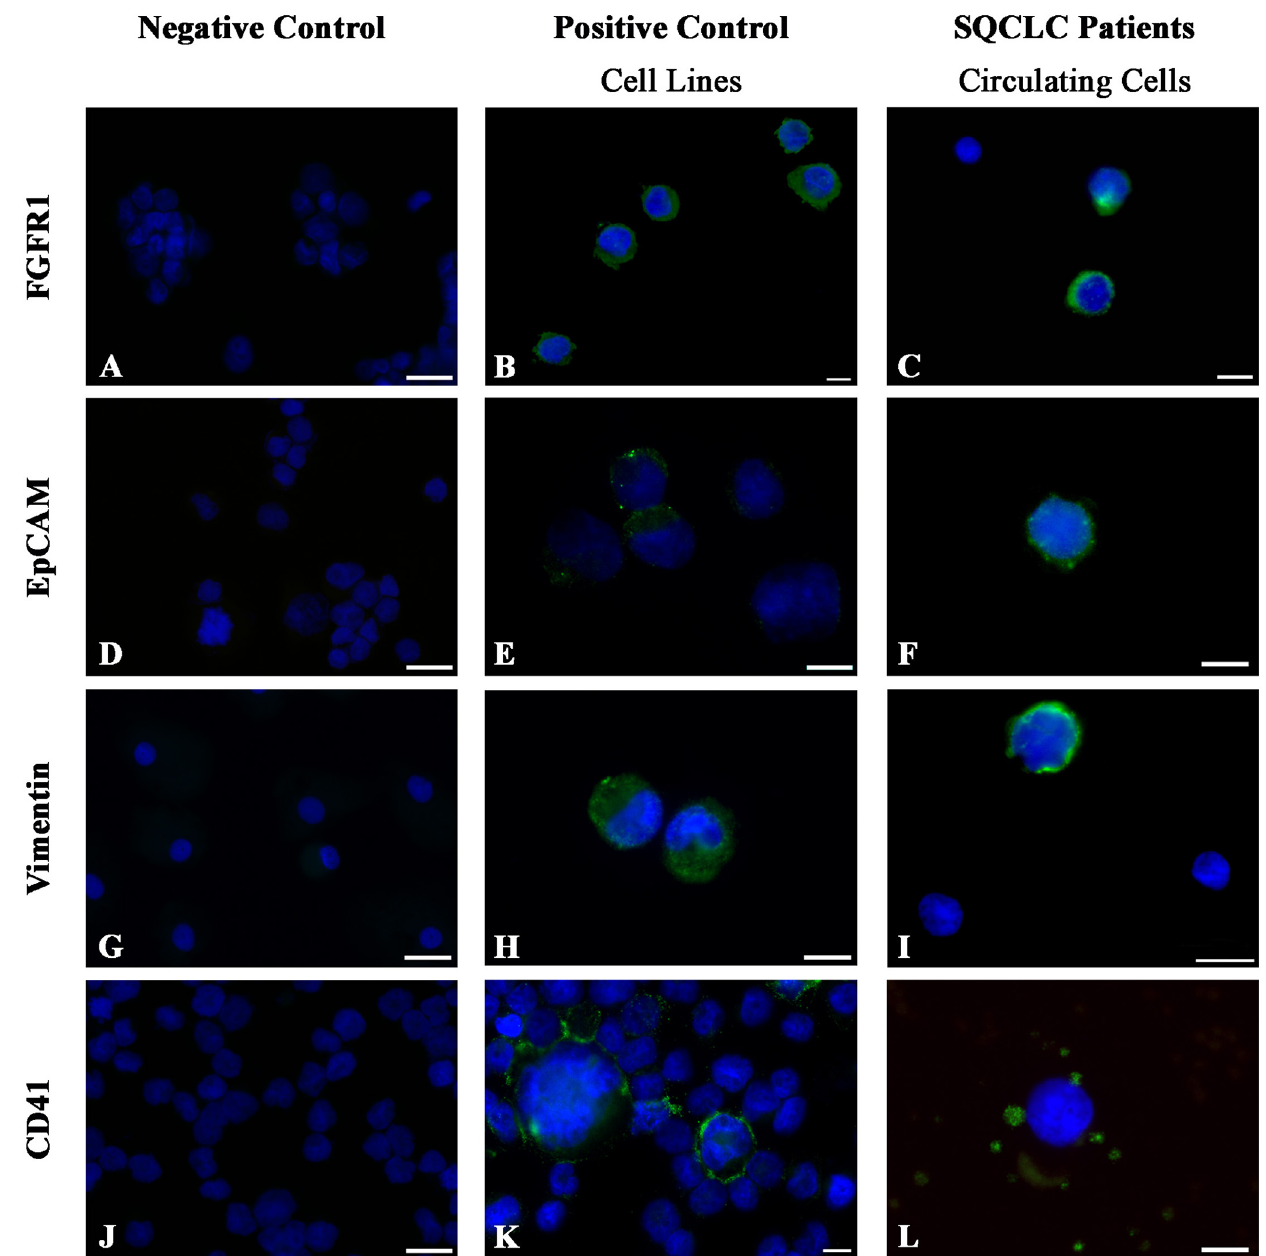
Fig 4. Immunocytochemical characterization of suspicious circulating elements obtained after depletion procedure from SQCLC patients. Images of cytospin preparations for each tested antigen are shown. All antigens were detected by immunofluorescence (green, FITC) and tested in control cell lines in the absence (negative control) or presence of the primary antibody (positive control) and in suspicious circulating elements (SCEs). FGFR1 negative control (A), FGFR1 positive H1703 cell line (B) and FGFR1 positive SCEs (C). EpCAM negative control (D), EpCAM positive H1703 cell line (E) and an EpCAM positive SCE (F). Vimentin negative control (G), vimentin positive hBM-MSC cell line (H) and a vimentin positive SCE (I). CD41 negative control (J), CD41 positive HEL cell line (K) and a CD41 negative SCE (L). Small green fluorescent dots in figure L correspond to platelets. In figures C and I, DAPI stained nuclei of cells showing no immunoreactivity were considered as leukocytes in virtue of their small size. Scale bars: A, D, G and J = 20 μ m; B, C, E, F, H, I, K and L = 10 μ m.